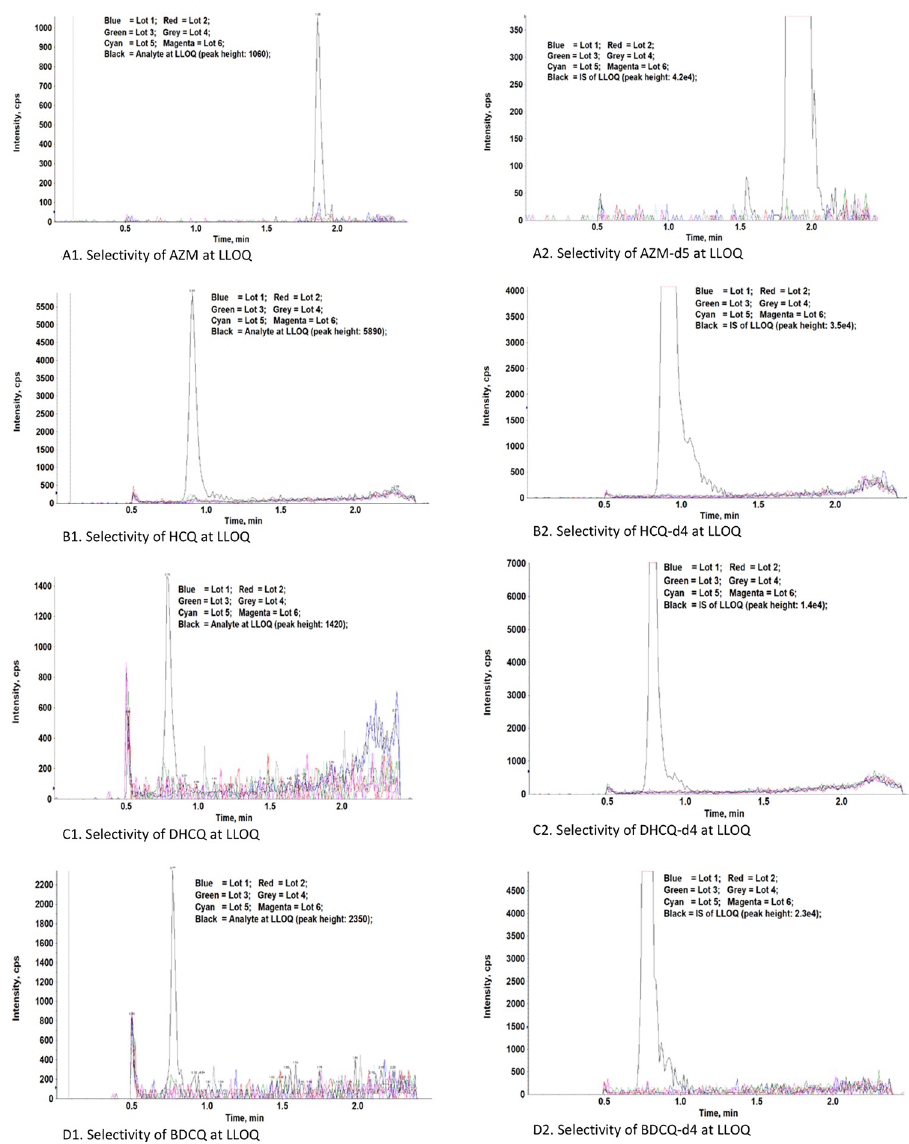
Fig 3. Chromatograms of six lots of blank plasma and LLOQ